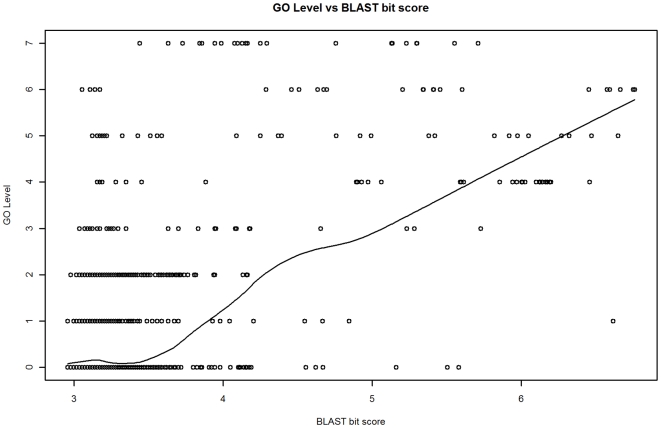
BLAST bit score (log) vs GO term depth.The trend shown is a lowess line. GO level generally increases with higher bit scores, however there is a high degree of variability in GO level over all ranges of bit scores, even for bit scores above 6.0 which indicate a high degree of sequence similarity.